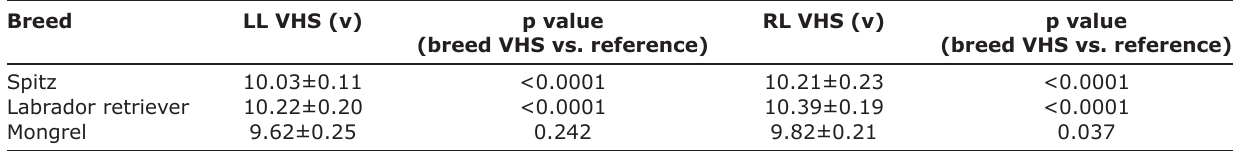
Values with different superscripts (a, b, c) differ significantly (p<0.05) between breeds; values with same superscript differ non-significantly (p>0.05). n=Number of animals in each breed, v=Length measured in vertebrae, LL=Left lateral, RL=Right lateral, LA=Long axis, SA=Short axis Table-2: Comparison of vertebral heart scores of Spitz, Labrador retriever and Mongrel dogs with published reference VHS of 9.7±0.5 vertebrae. Breed LL VHS (v) p value RL VHS (v) p value (breed VHS vs. reference) (breed VHS vs. reference) Spitz